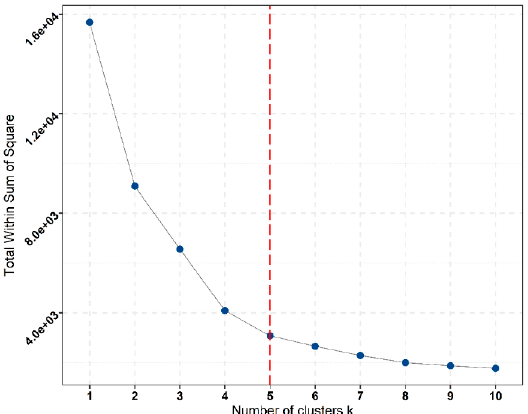
Figure 10. Plot of K = 1 to 10 clusters and the corresponding total cluster variance. The inflection point can be defined at K = 4 or 5. Red line indicates the chosen K = 5.